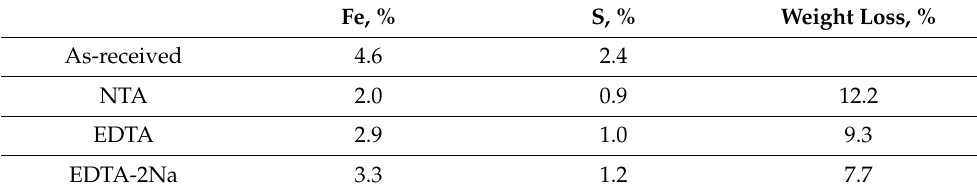
Table 3. Iron and sulfur contents in as-received and leached shungite samples. Fe, % S, % Weight Loss, %